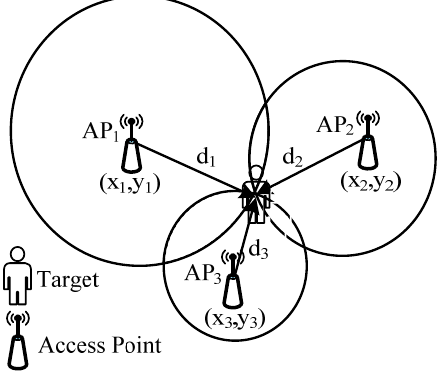
Figure 2. RSSI ‐ based trilateration. Figure 2. RSSI-based